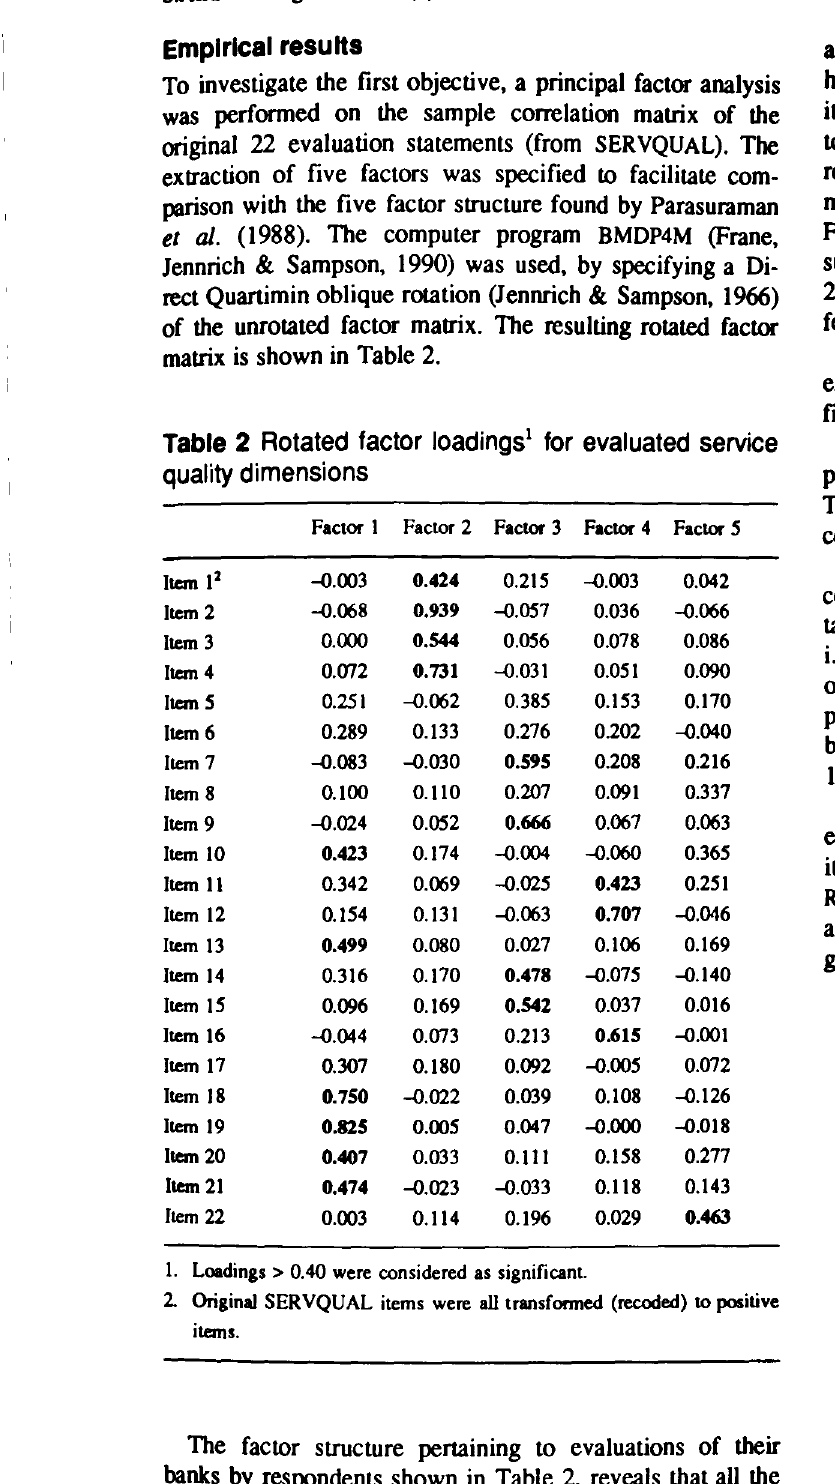
Table 3 Empirical factor structure for